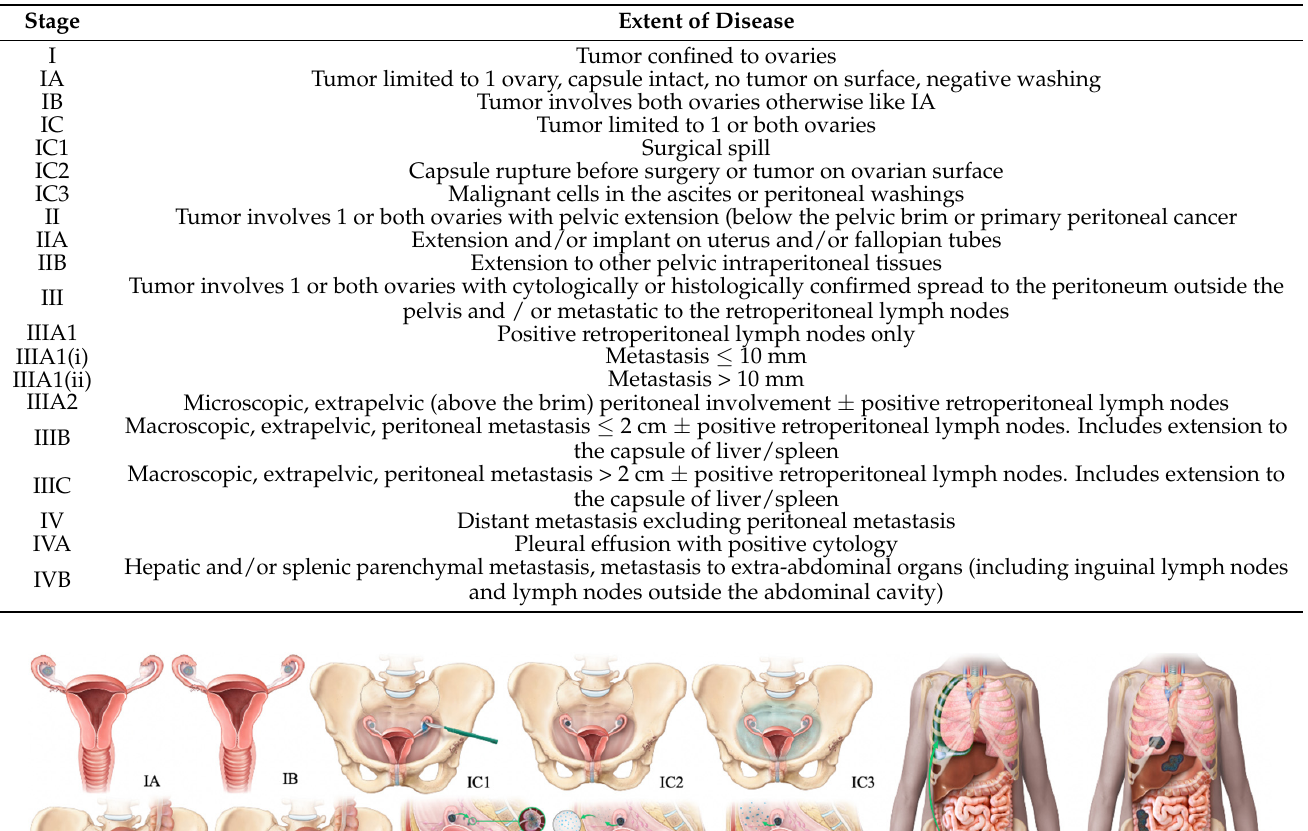
Table 9. The International Federation of Gynecology and Obstetrics (FIGO) staging of ovarian cancer (2014).